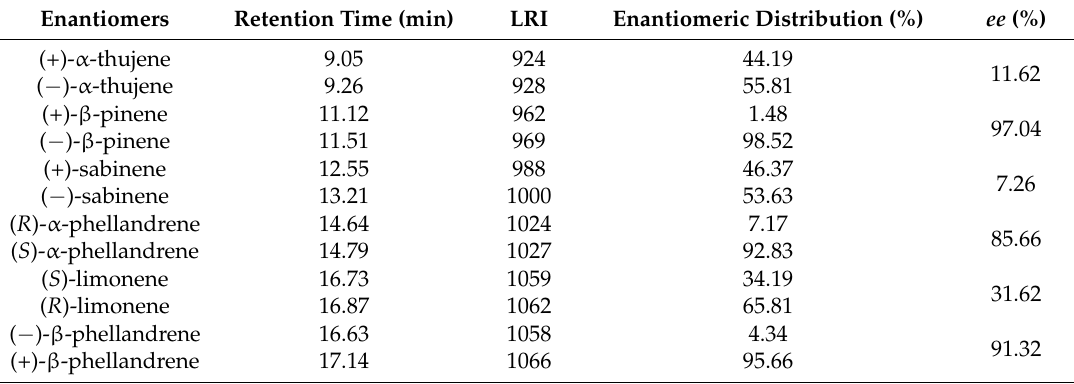
Table 2. Enantiomeric analysis of the essential oil from flowers of Lepechinia mutica on a